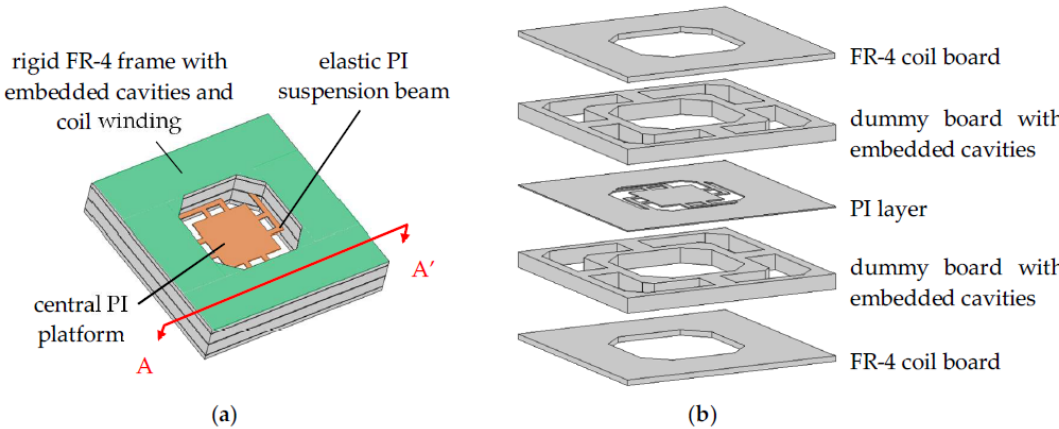
Figure 1. Proposed harvester fabricated based on a commercial Rigid-Flex printed circuit boards (PCB) technology, ( a ) schematic view; ( b ) exploded view.